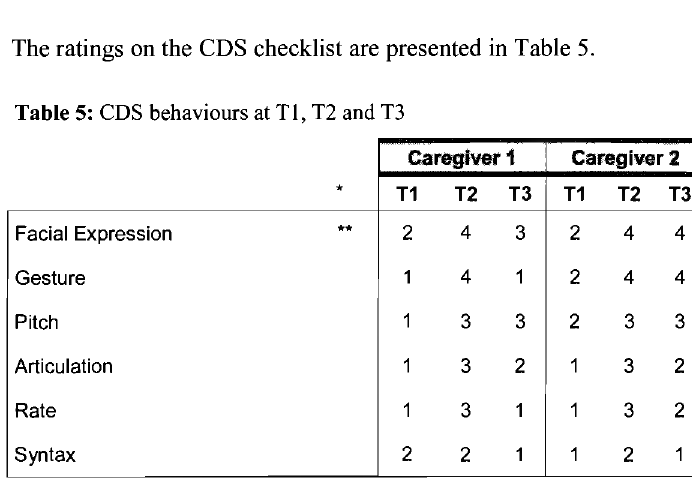
Table 5: CDS behaviours at T l, T2 and T3